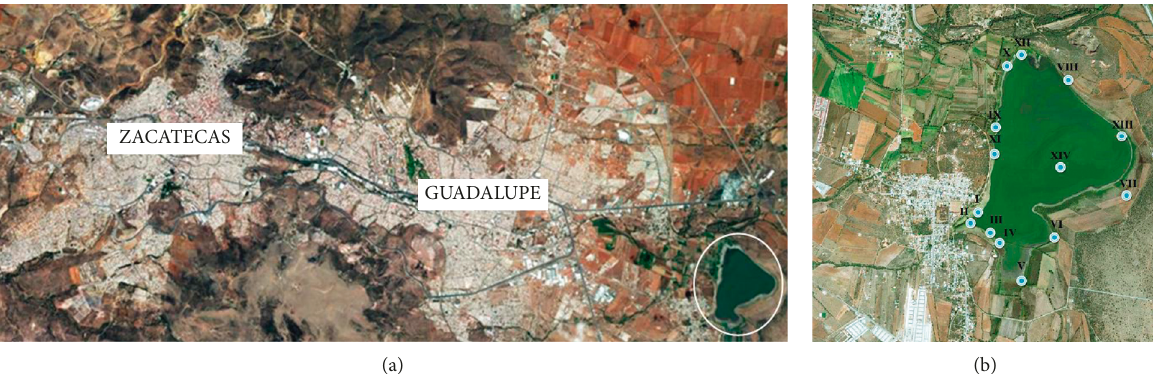
Figure 1: The Zacatecas metropolitan area. (a) Location of the La Zacatecana Lagoon in reference to the cities of Zacatecas and Guadalupe. (b) Sampling sites in the La Zacatecana